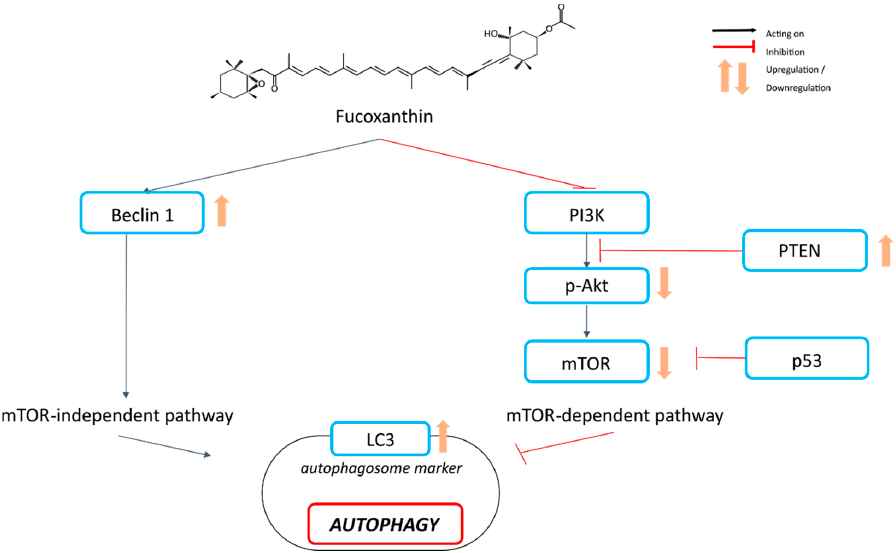
Figure 6. Induction of autophagy in cancer cells by fucoxanthin.